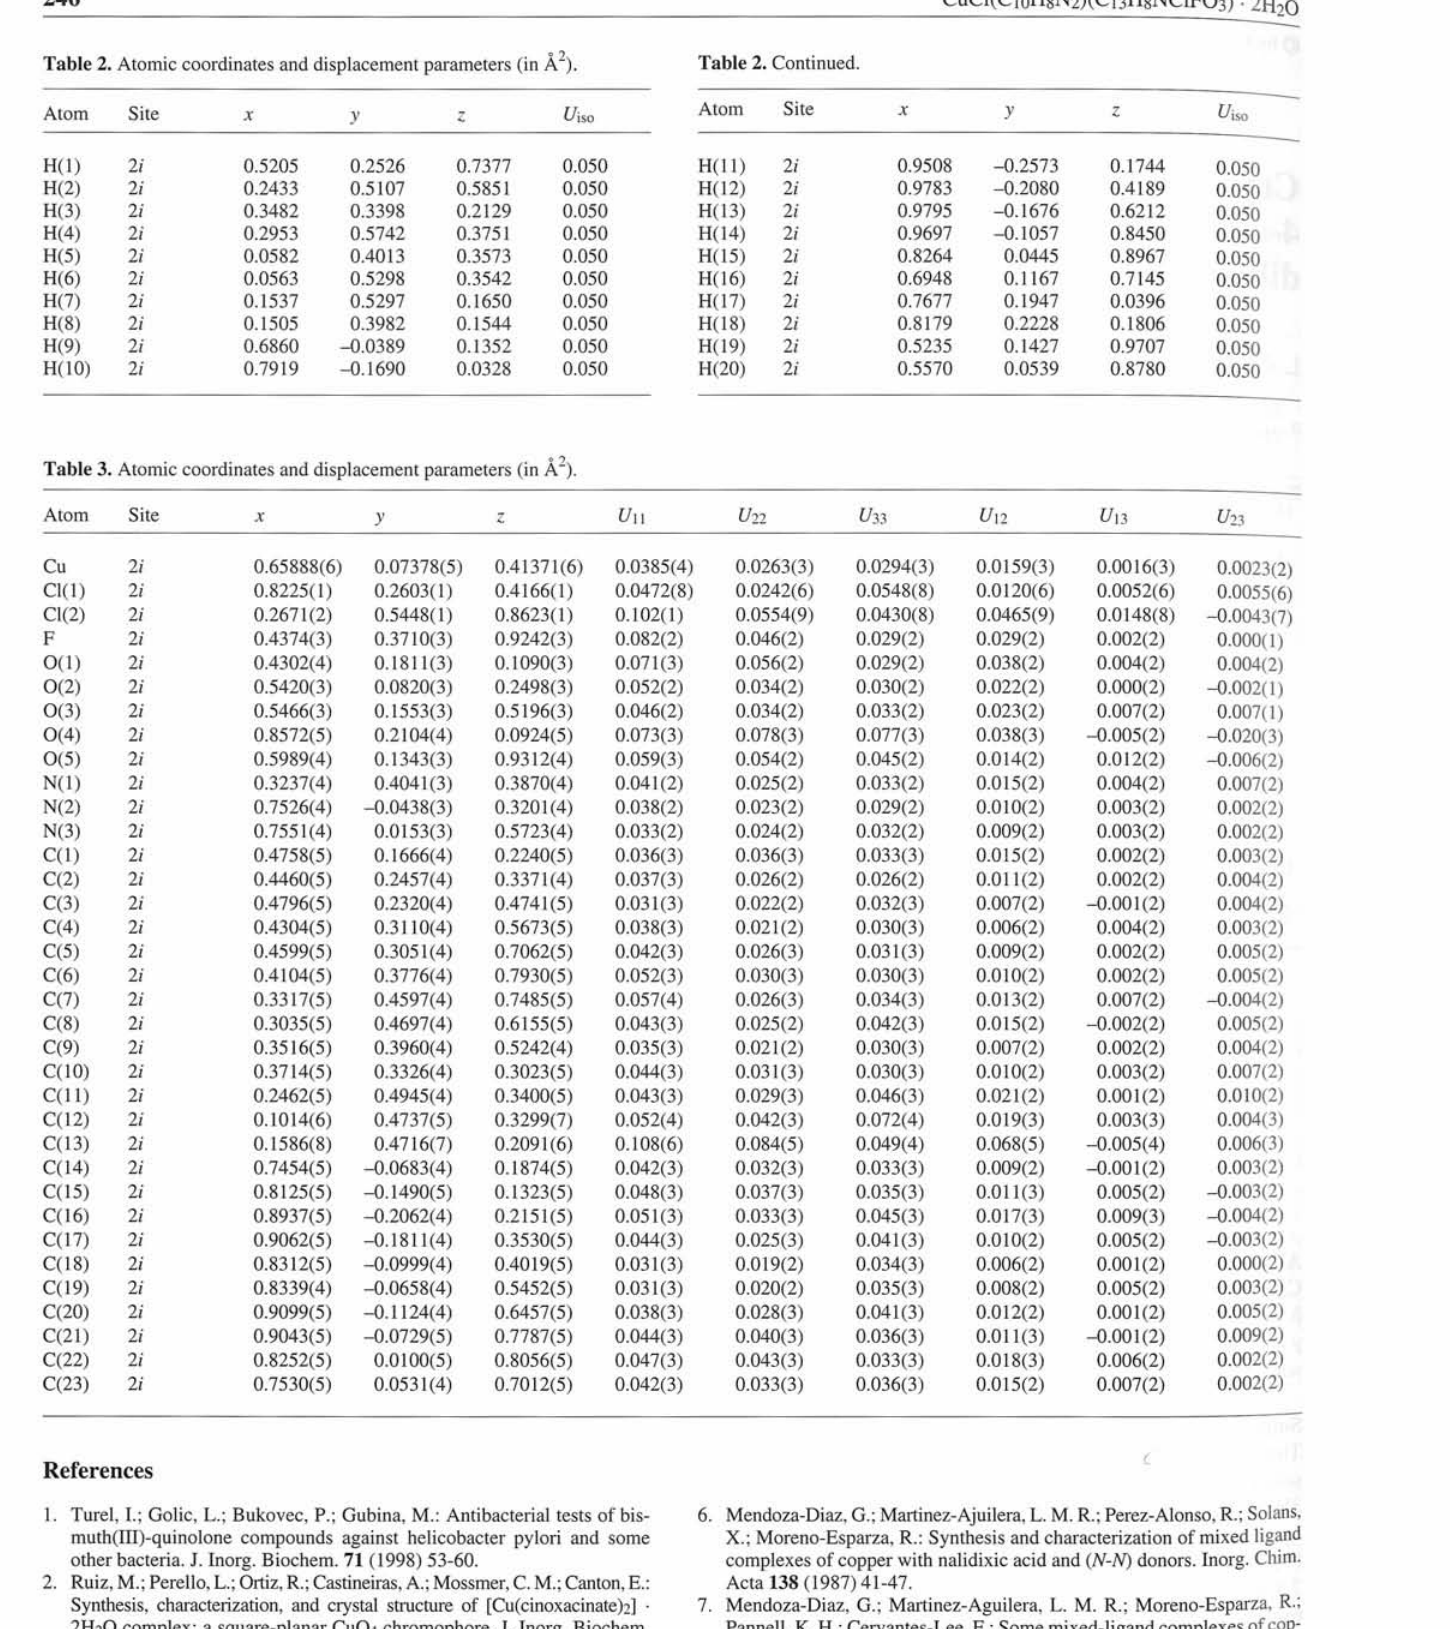
Table 3. Atomic coordinates and displacement parameters (in A 2